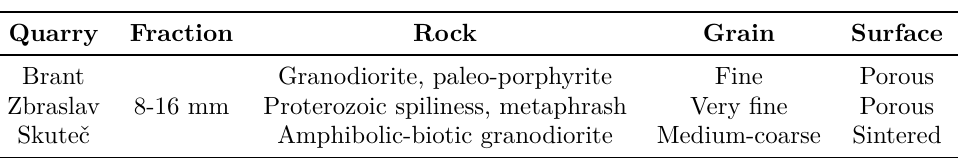
Table 1. Basic properties of aggregate used.